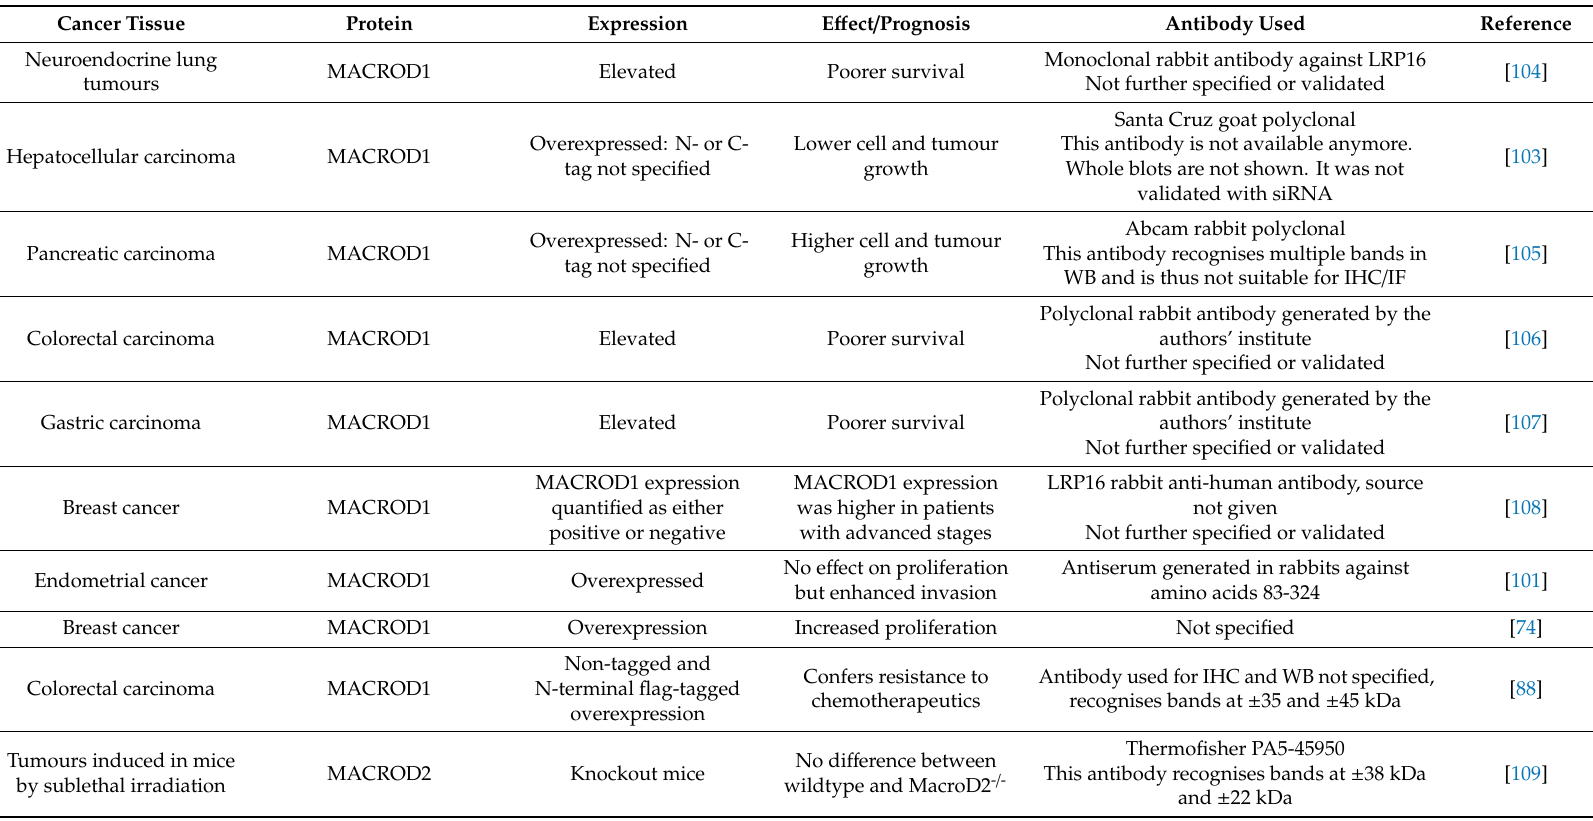
Table 2. Summary of studies studying the e ff ect of MACROD1 and MACROD2 protein levels on cell and / or tumour